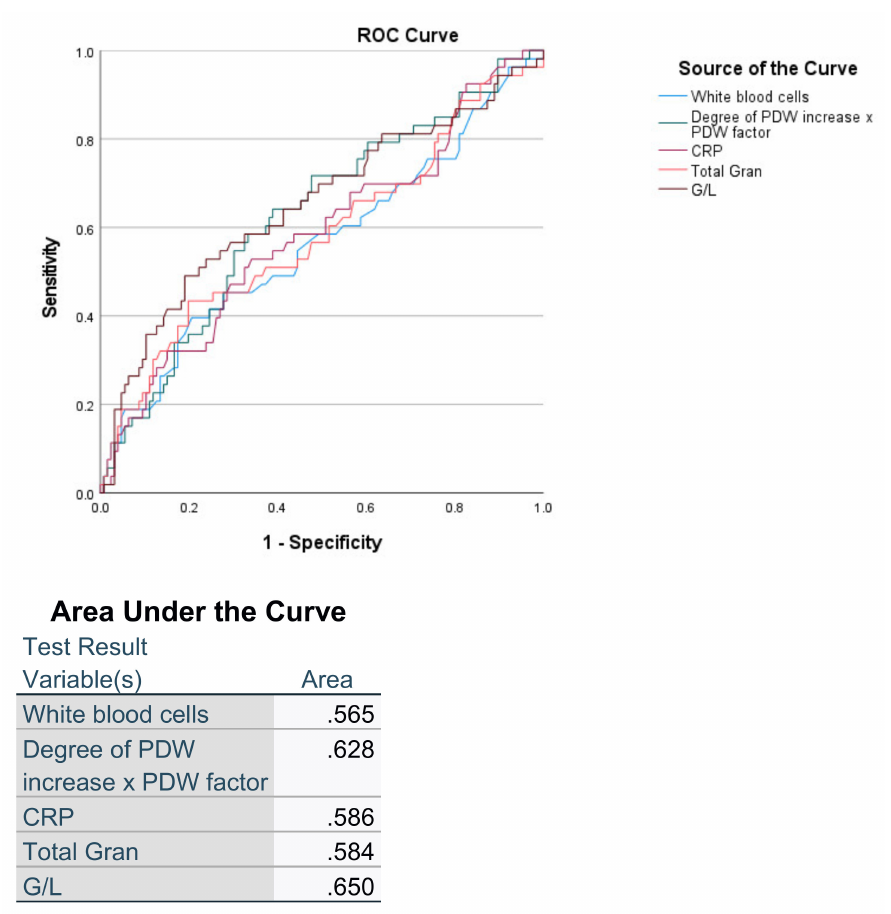
Figure 5. ROC curve comparing sensitivity and specificity of predicting the mortality in patients with ARDS between D-PDWf, CRP, WBC, granulocytes and G/L. The above values of the area under the ROC curve show poor to sufficient